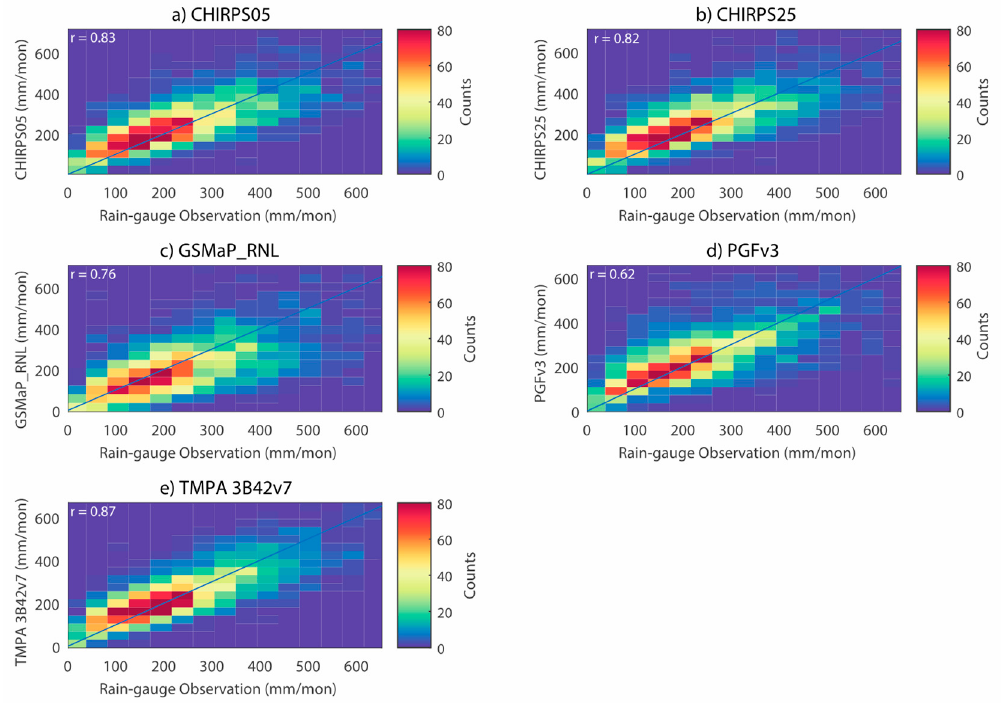
Figure 2. The 2-D histogram of total monthly rainfall station data compared to: ( a ) CHIRPS05, ( b ) CHIRPS25, ( c ) GSMaP_RNL, ( d ) PGFv3 and ( e ) TMPA 3B42v7. The right scale in the y -axis indicates count of points.